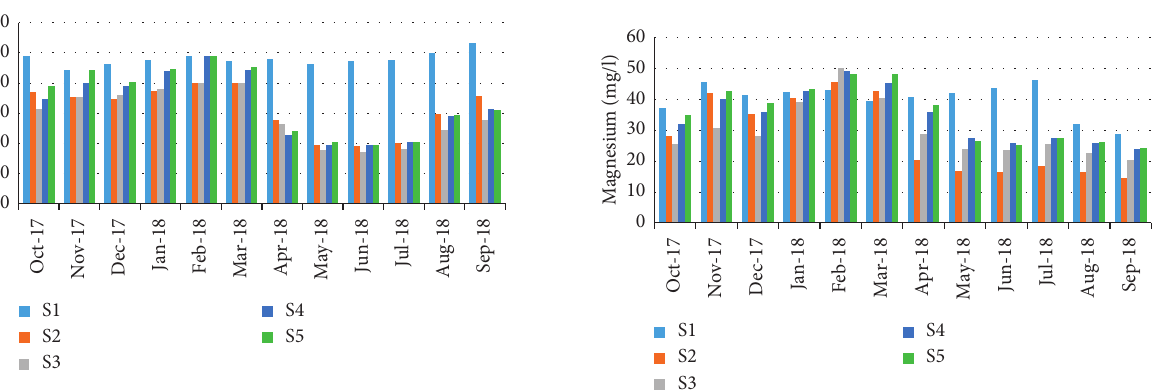
Figure 9: Spatial-temporal variation of calcium in the Zegzel watercourse.